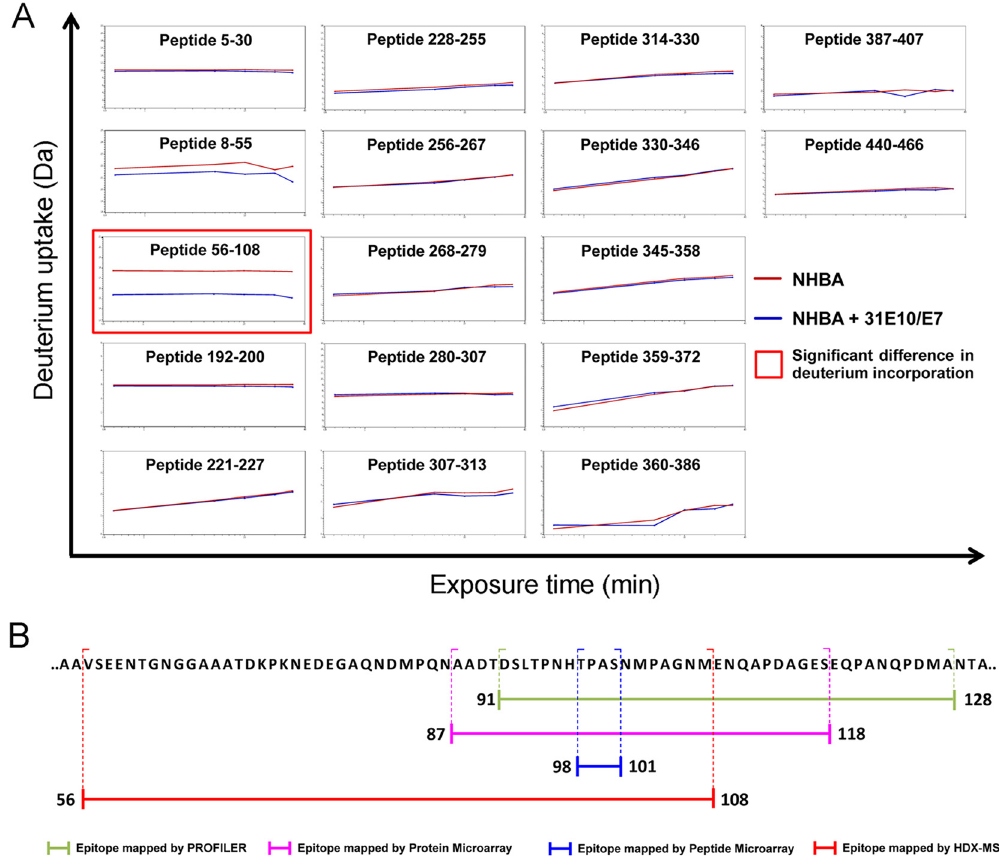
Fig 6. HDX-MS analysis. A, time course of deuterium incorporation for the peptic peptides covering the NHBA sequence. The blue curves correspond to the complex NHBA-mAb 31E10, while the red curves derived from NHBA alone. The peptide showing a significant difference of deuterium uptake between the free and bound forms is highlighted with a red box (peptide Val 56-Met 108). Data herein reported are representative of three independent replicates. Replicates 2 and 3 of the deuterium incorporation time course for peptide 56 – 108 are reported in S3 Fig. B, schematic representation of the overlapping regions identified by the different approaches used in the present study. Shown are data obtained from one experiment, representative of